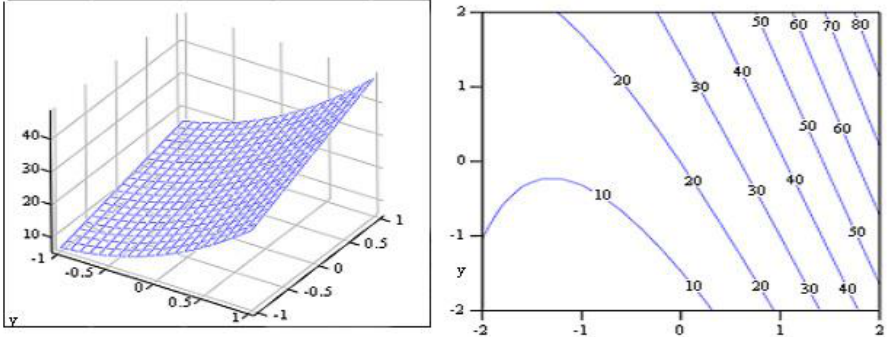
Figure 4. The graph and contour curves of the dependence of the criteria Y on the factors х 3 , х 2 for cherries, when х 1 = 0.